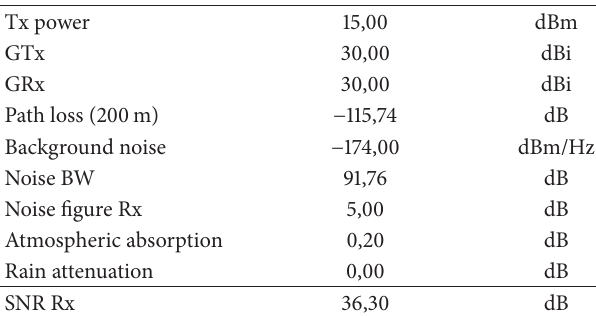
Table 2: Example link